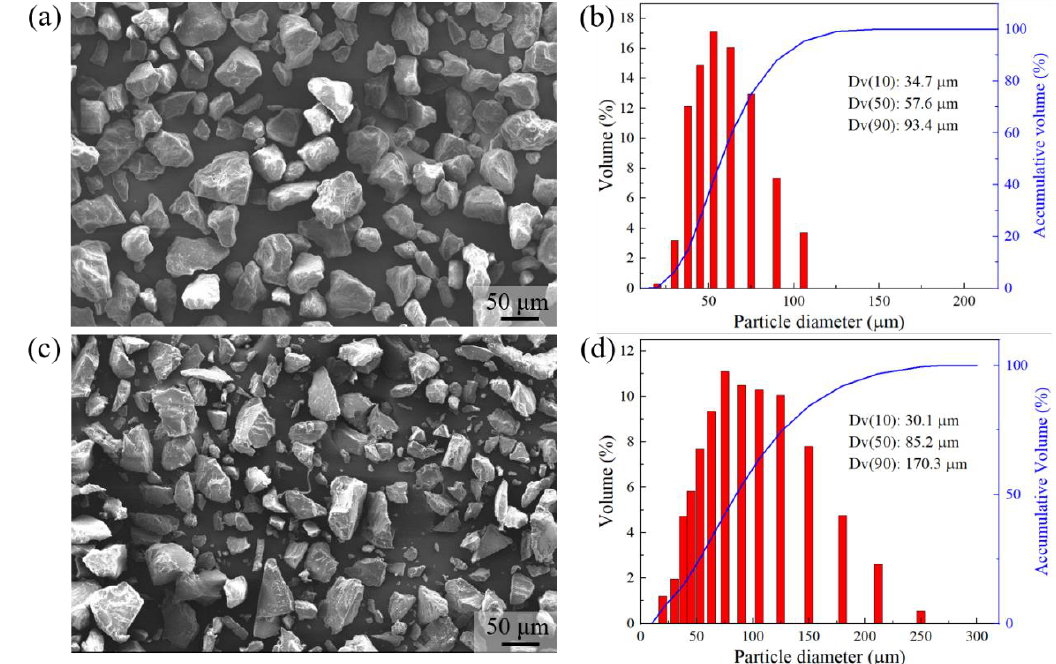
Figure 2. Granulometric morphology and powder size distribution of powders: ( a , b ) PA11 and ( c , d ) TPU powders.